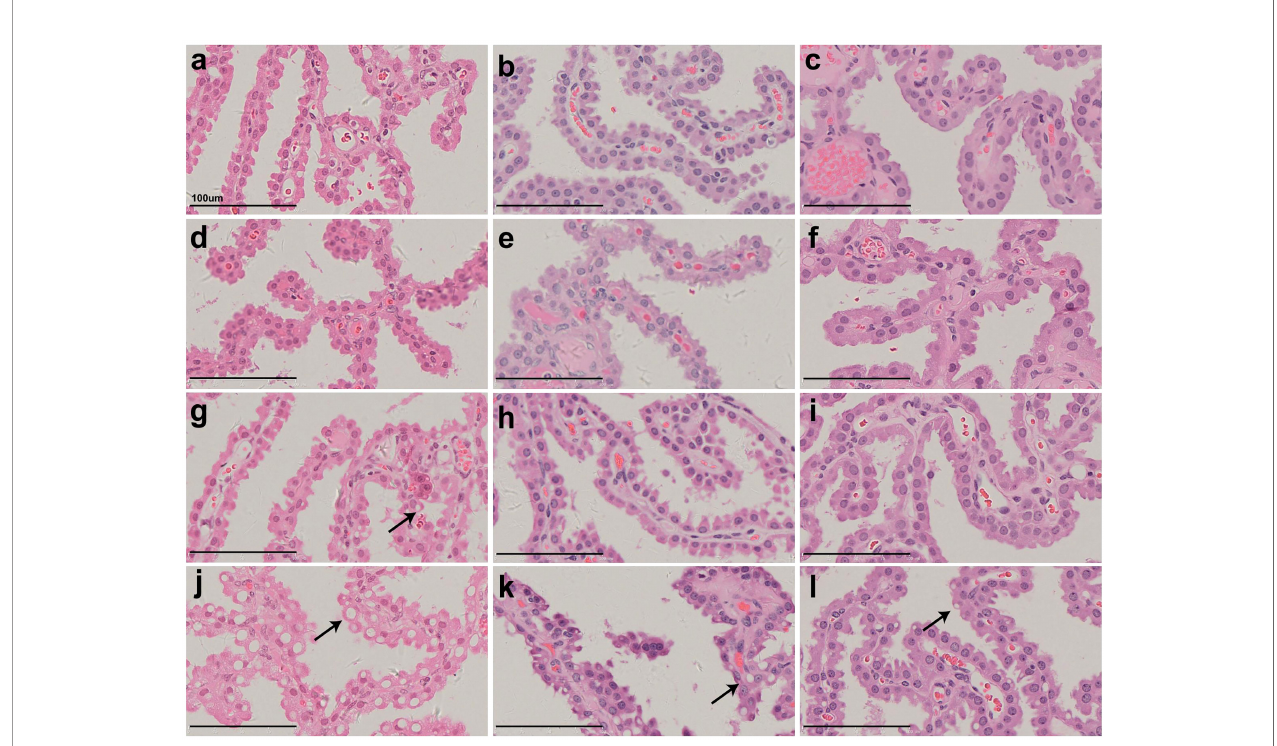
FIGURE 3 | H&E staining of cynomolgus monkeys CP epithelium with 52-week administration of Jintrolong and after 104-/157- week recovery. (A) Excipient control group. (B) Excipient control group after 104-week recovery. (C) Excipient control group after 157-week recovery. (D – F) 0.3 mg/kg/week Jintrolong group at 52-week, after 104-week recovery, after 157-week recovery, respectively. (G – I) 1 mg/kg/week Jintrolong group at 52-week, after 104-week recovery, after 157-week recovery, respectively. (J – L) 3 mg/kg/week Jintrolong group at 52-week, after 104-week recovery, after 157-week recovery, respectively. Arrows indicate representative cytoplasmic